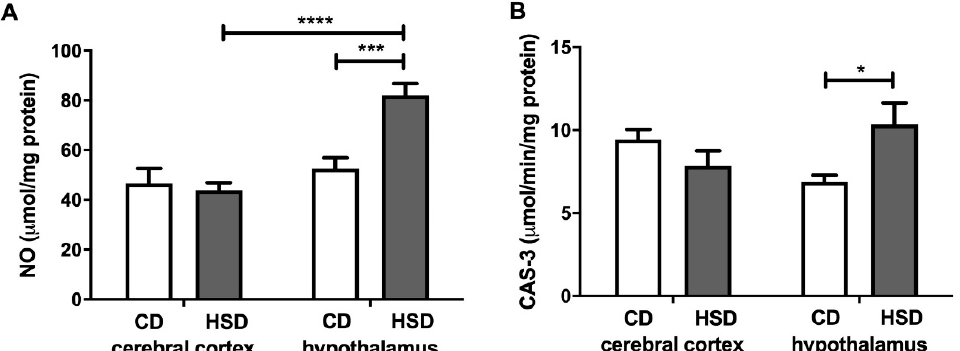
Figure 6. Brain apoptosis markers (nitric oxide ( A ) and caspase 3 ( B )) in the control and HSD-fed rats. Values are means ± SEMs; n = 10 * differences statistically important at p < 0.05, *** p < 0.0005 and **** p < 0.0001. CAS-3—caspase 3; CD—control diet; HSD—high-sucrose diet; NO—nitric oxide.